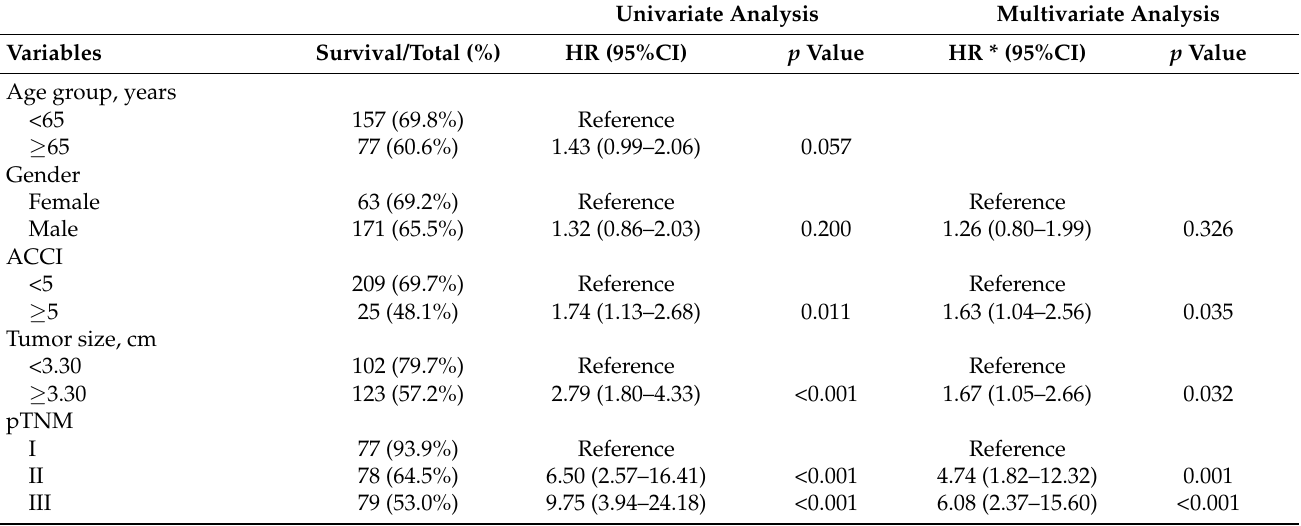
Table 3. Cox proportional hazard analysis of the prognostic predictors associated with overall survival among patients with esophageal squamous cell carcinoma (n = 352). Univariate Analysis Multivariate